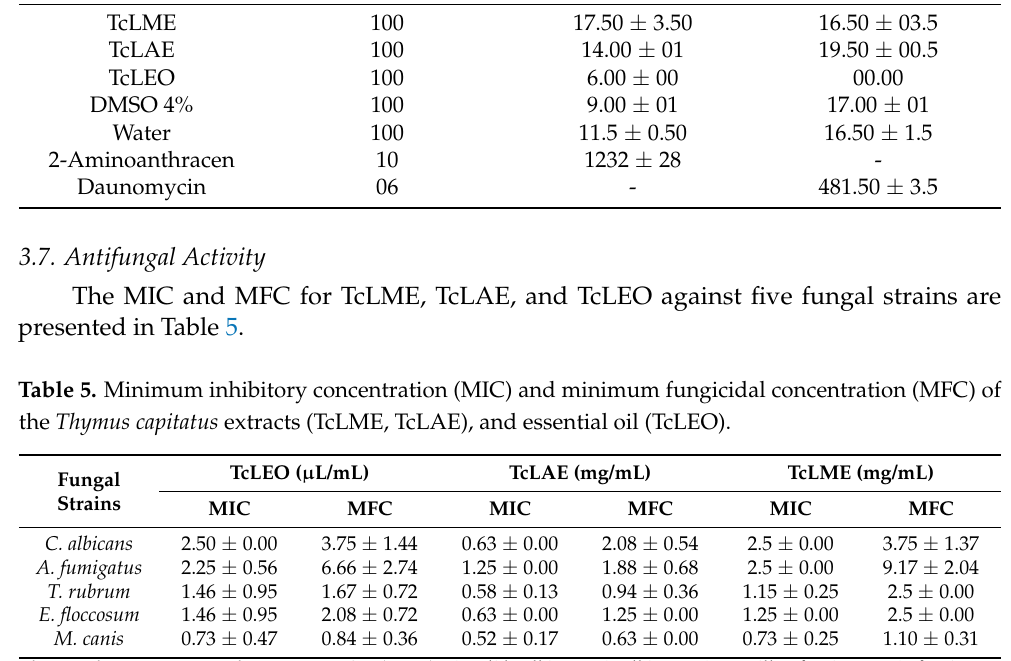
Table 4. Genotoxicity of Thymus capitatus extracts and essential oil against Salmonella Typhimurium TA98 (+S9) and bacterial strain TA98 ( − S9). Extracts Solvent Dose/Plate ( µ g/mL)